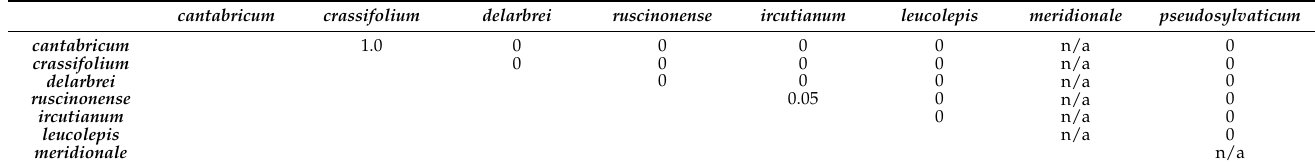
Table 3. Bonferroni-corrected p -values for pairwise tests of geographical overlap, i.e., sympatry. Corrected p -values are truncated to